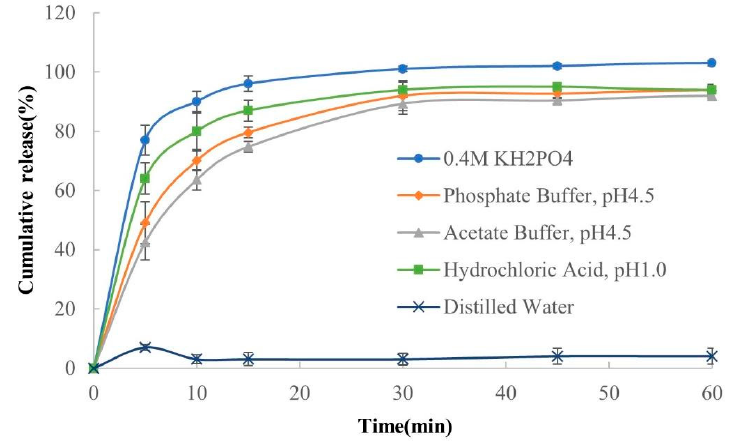
Figure 16. The release profiles of drug–resin complex in different dissolution media ( n = 3, mean ± SD). Figure 16. the release profiles of drug–resin complex in different dissolution media ( n =3, mean ± SD). According to Boyd’s and Bhaskar’s theory, the release profiles from drug–resin com- plexes were entered into the particle diffusion (Figure 17A) and film diffusion (Figure 17B)